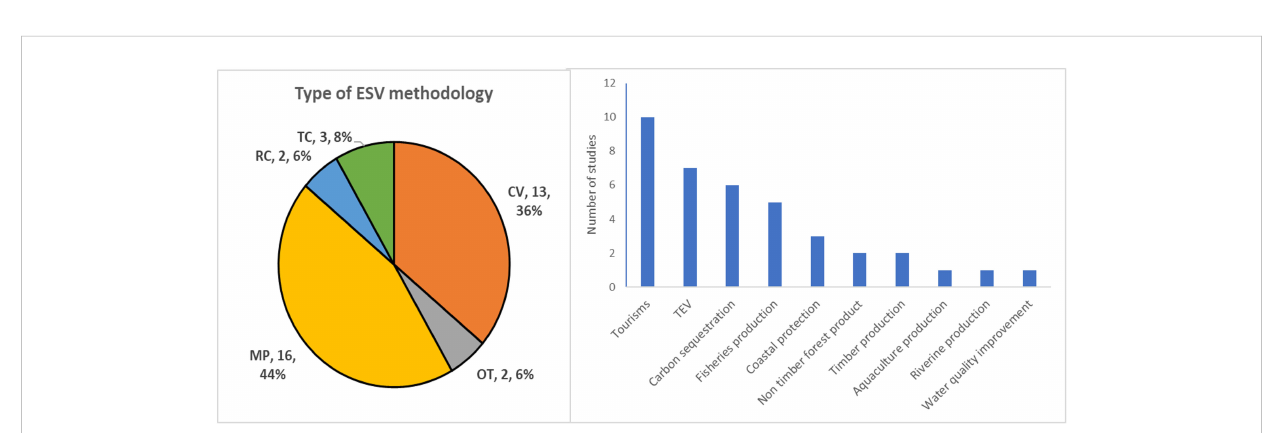
FIGURE 2 Summary of ecosystem service valuation (ESV) methodologies and ecosystem services that had been valued in Malaysia. CV = contingent valuation; MP = market price; BT = bene fi t transfer; RC = replacement cost; TC = travel cost; OT = others including the bene fi t transfer and ecosystem service valuation method (remote sensing).